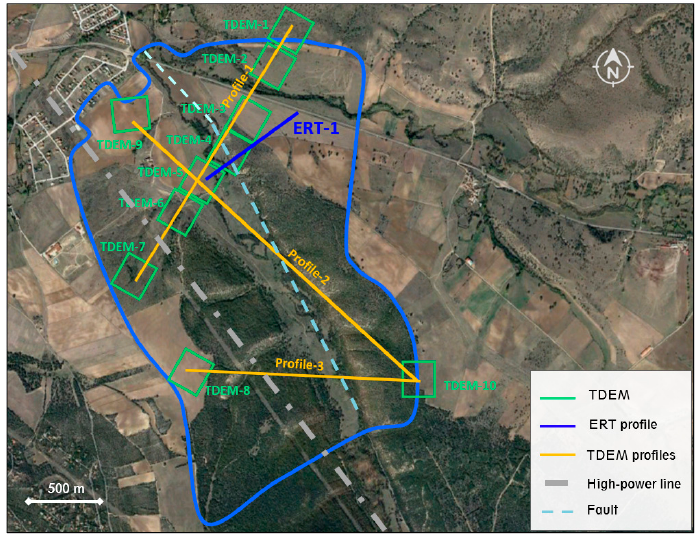
Figure 5. Location of the geophysical tests (TDEM and ERT) performed in the area under study.